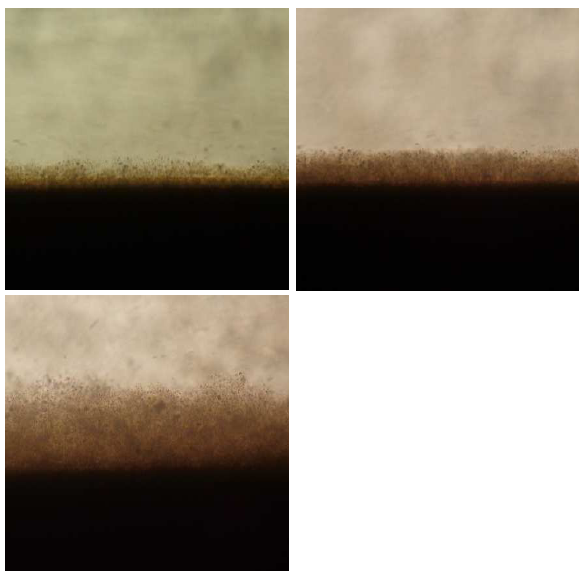
Fig. 7. Images captured at the beginning, in the middle and at the end of the 15 cm hollow fiber membrane after 1 hour of filtration and 33 mm/s CFV.